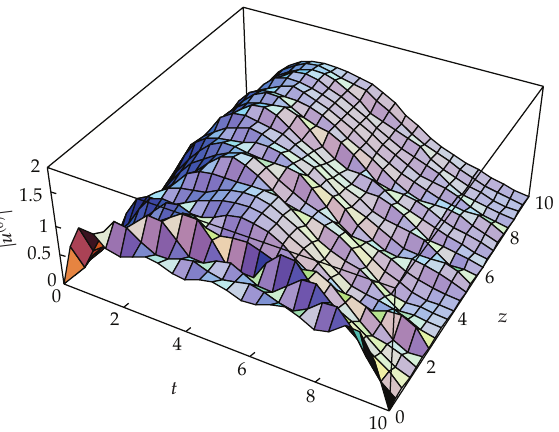
Figure 25: The zero-order approximation of | u (cid:3) 0 (cid:4) | at α (cid:8) 1, T (cid:8) 10, γ (cid:8) 02 with considering only one term in the series (cid:3) M (cid:8) 1 (cid:4)